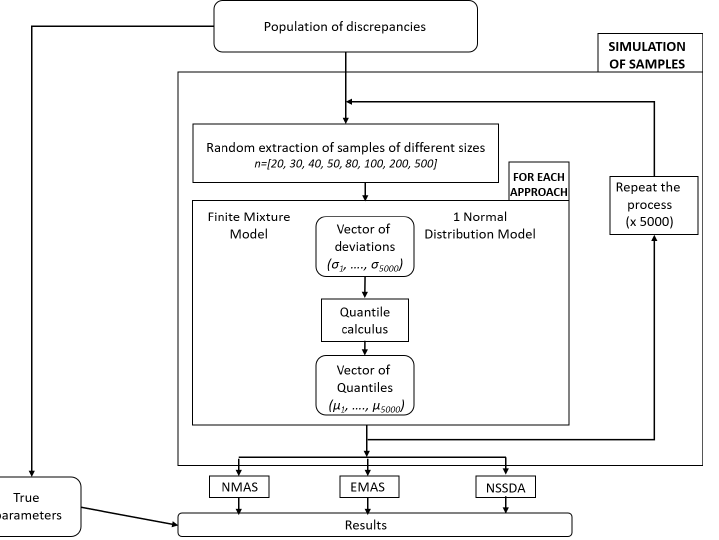
Figure 1. The simulation process for the comparison of the analyzed positional accuracy assess- ment approaches.